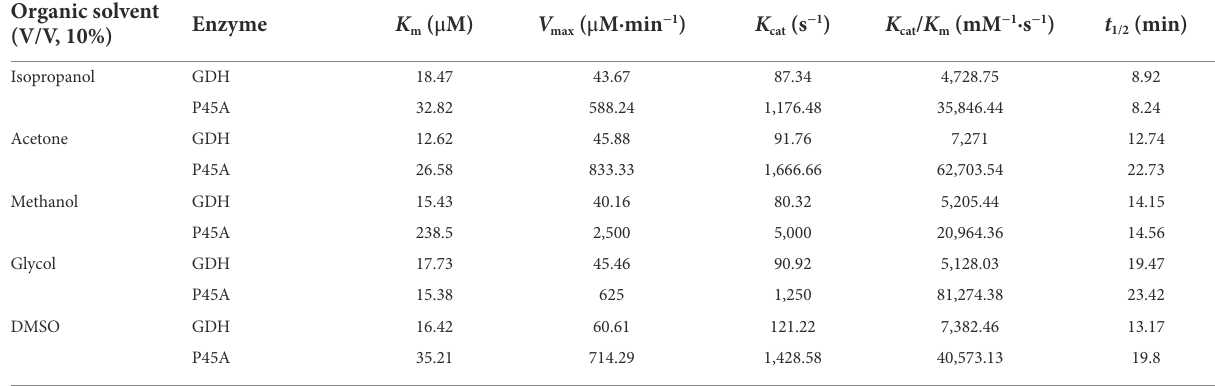
TABLE 3 Kinetic parameters of GDH and P45A in organic